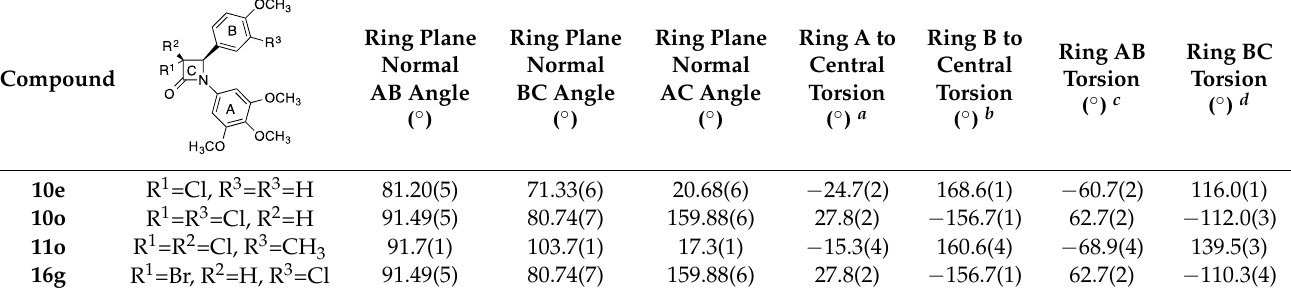
Table 2. X-ray Crystallographic Data for β -lactams 10e , 10o , 11o and 16g .